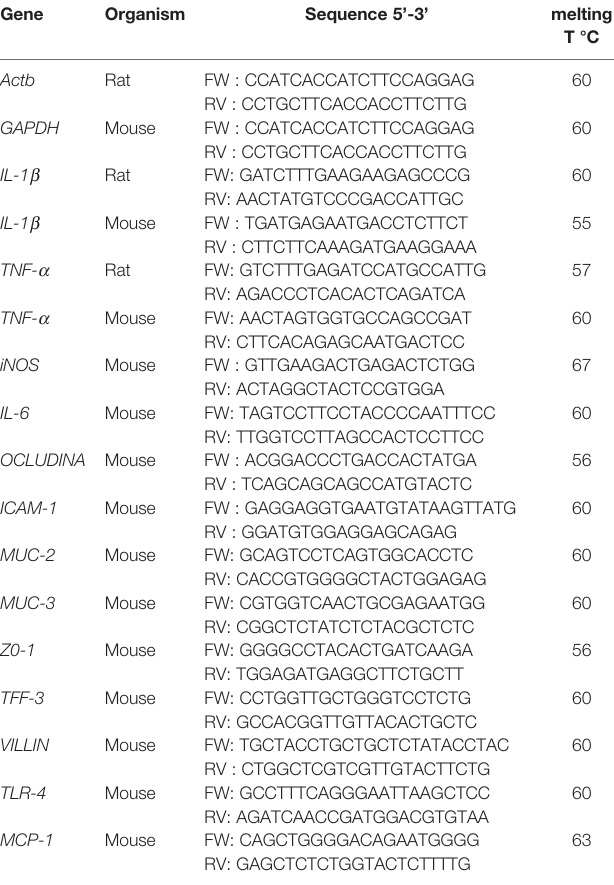
TABLE 1 | Primer sequences used in reverse transcription − quantitative polymerase chain reaction (RT-qPCR) assays for in vivo models